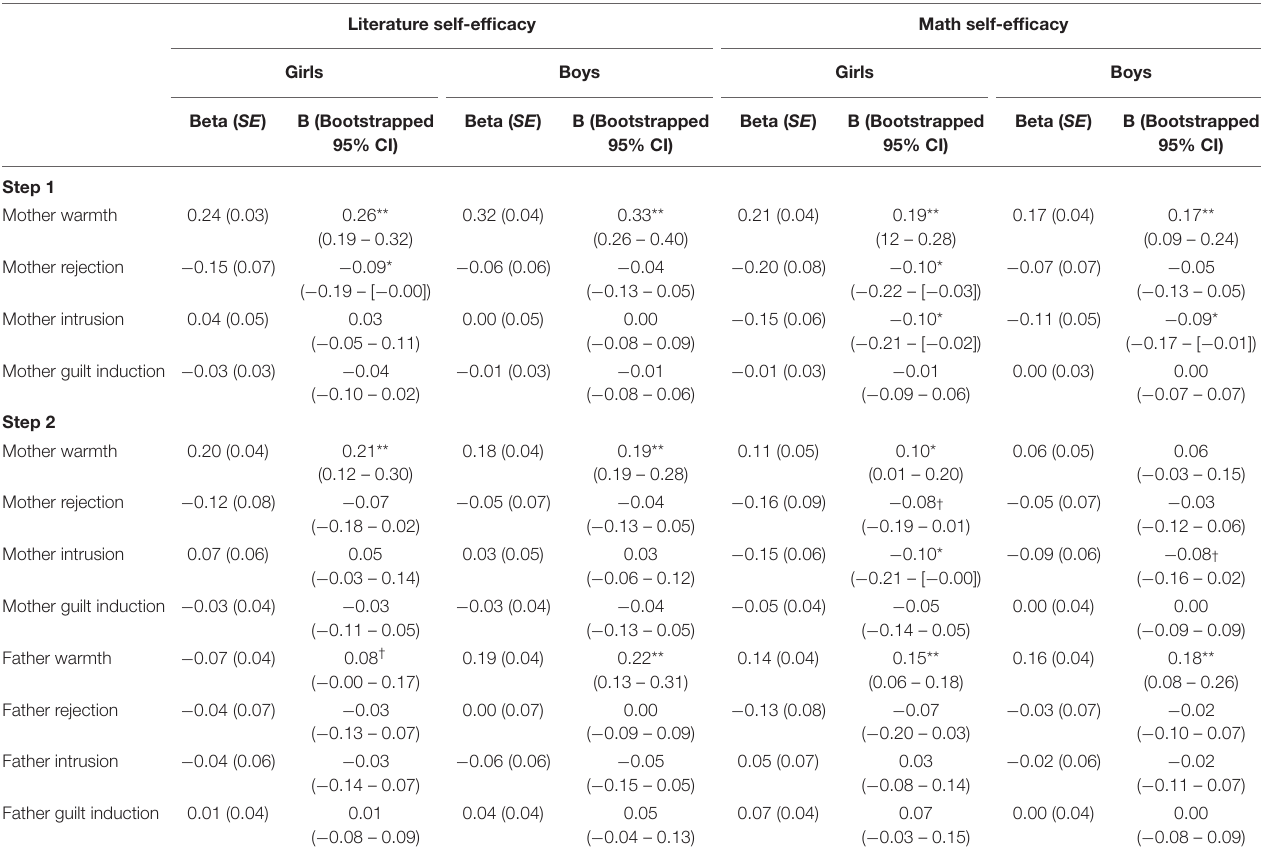
TABLE 2 | Maternal and paternal parenting behaviors predicting girls’ and boys’ literature and math